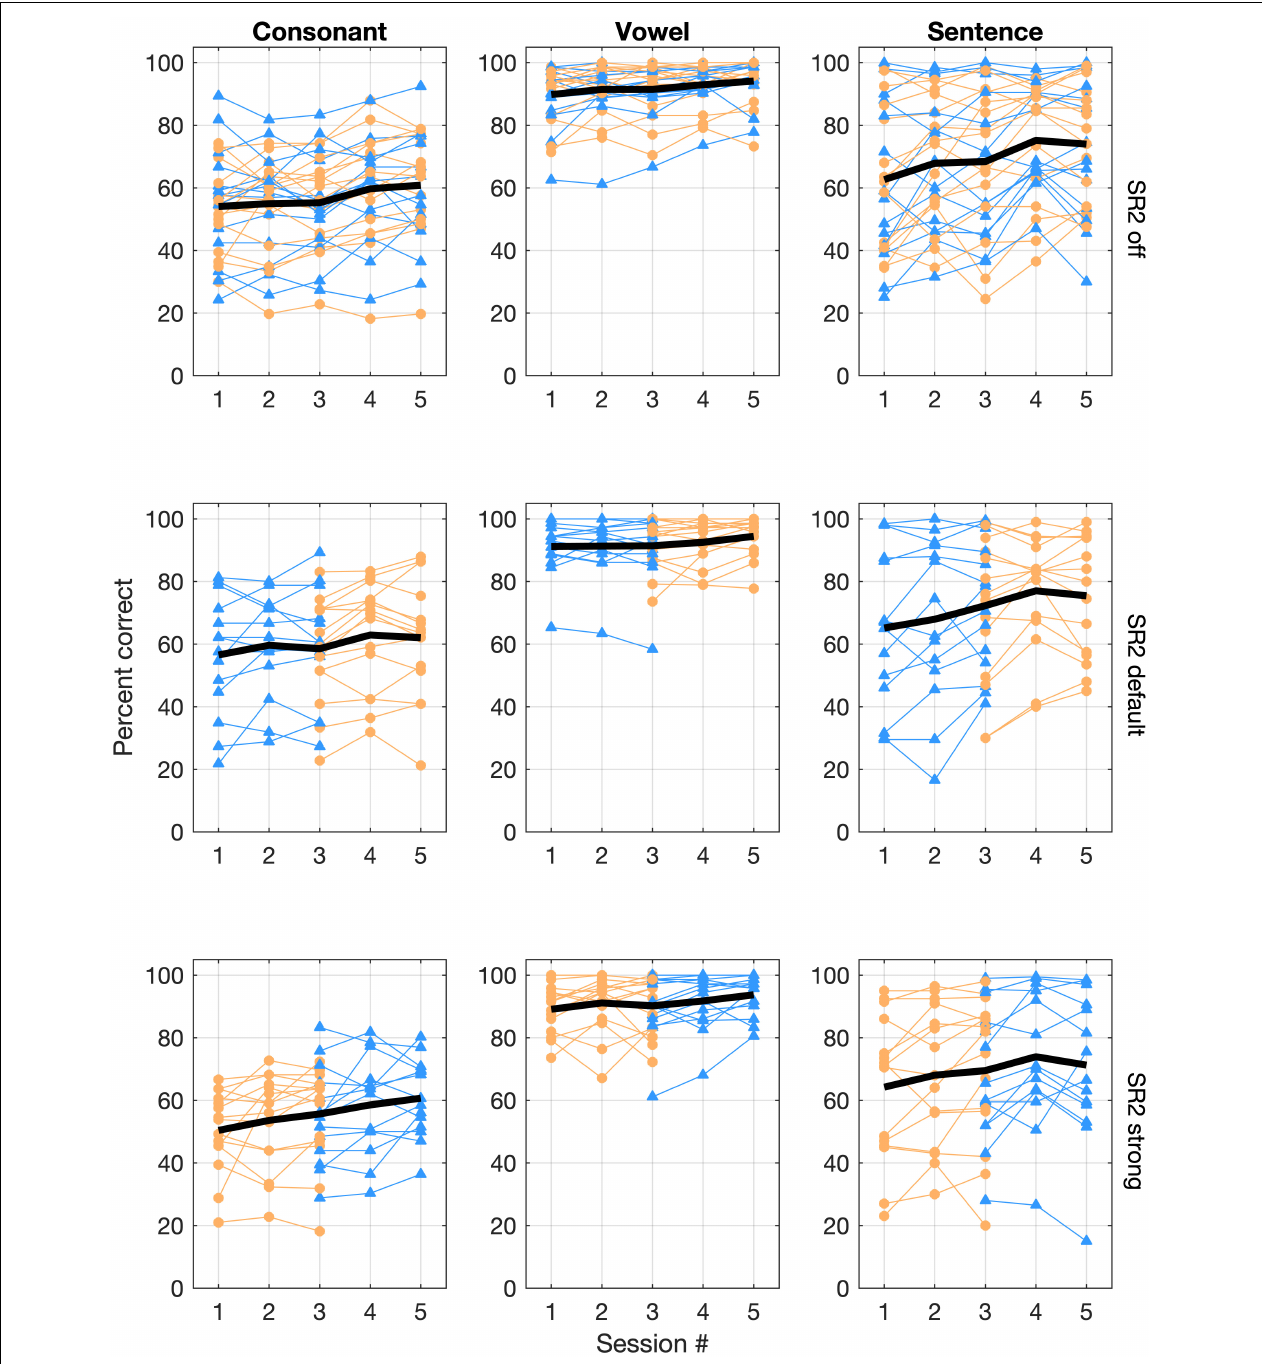
FIGURE 5 | Individual and group mean speech-recognition performance. Consonant and vowel recognition in quiet, and sentence recognition in noise (+5 dB SNR) are represented in the three columns whereas performance for the three SR2 settings is represented in the three rows of panels. In each panel, performance scores (% correct) are plotted as a function of test sessions. Each thin line represents one participant. Those in Group A are plotted with triangles in blue whereas those in Group B are plotted with circles in orange. The thick black line represents the overall group mean performance.